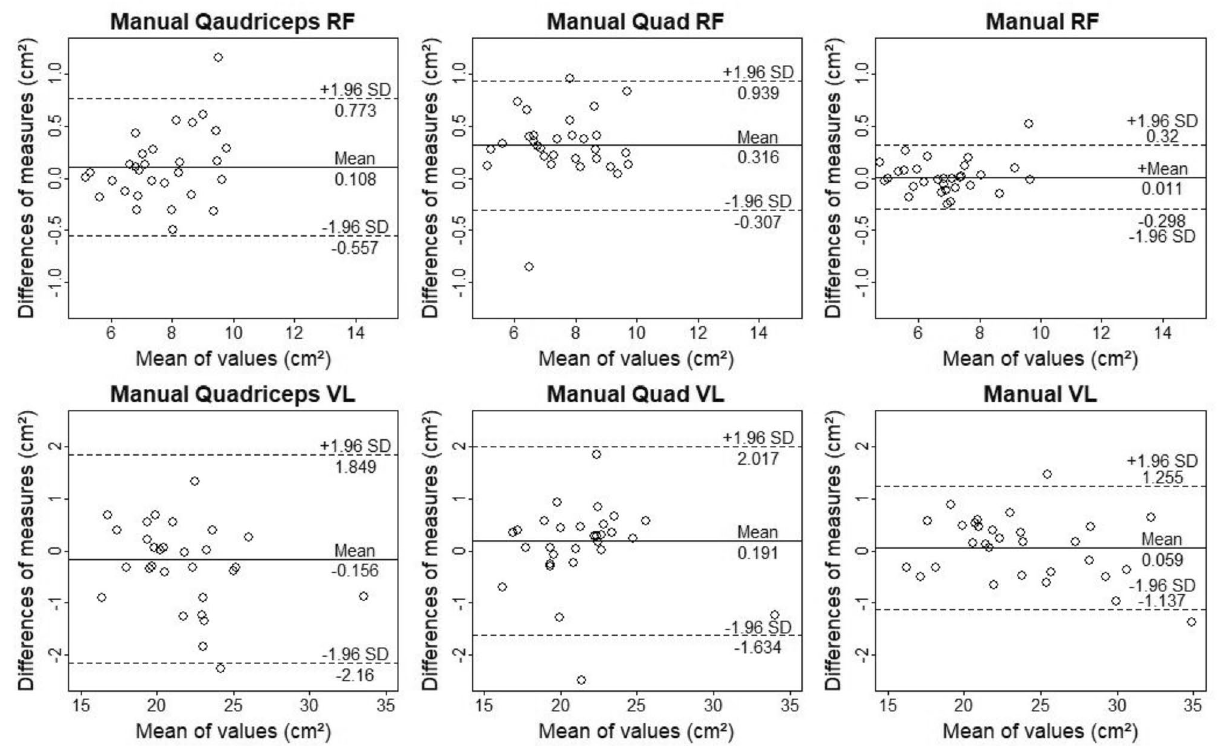
Figure 3. Bland–Altman plots of all modes using “Manual” outline-finder option comparing measurements of investigator1 to measurement of investigator2. M. rectus femoris (RF) and m. vastus lateralis (VL). The differences between measurements are plotted against measurement means. Dotted and solid lines illustrate 95% limits of agreement and bias. During the “Quadriceps” modalities both muscles are analysed in one image. During the “Quad” modalities, only one muscle is evaluated per image even though both muscles are displayed. During RF and VL modalities, both muscles were analysed in separate